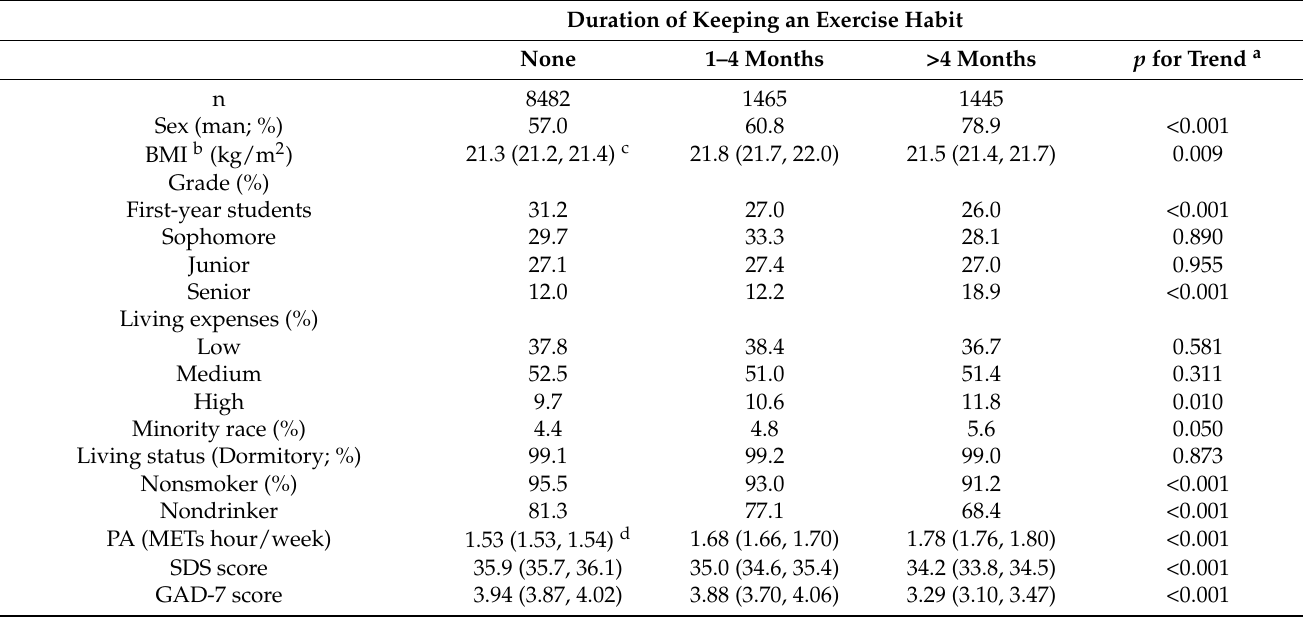
Table 1. Participant characteristics according to categories of duration of keeping an exercise habit. Duration of Keeping an Exercise